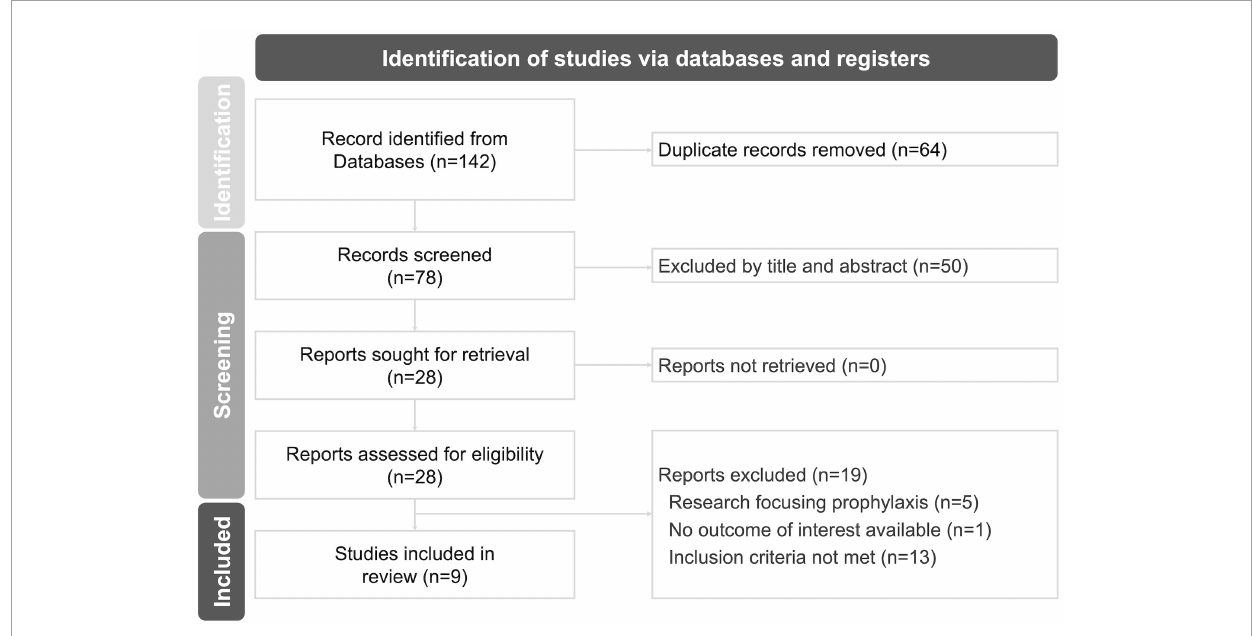
FIGURE1 Meta-analysis flow-chart diagram according to the PRISMA guideline.